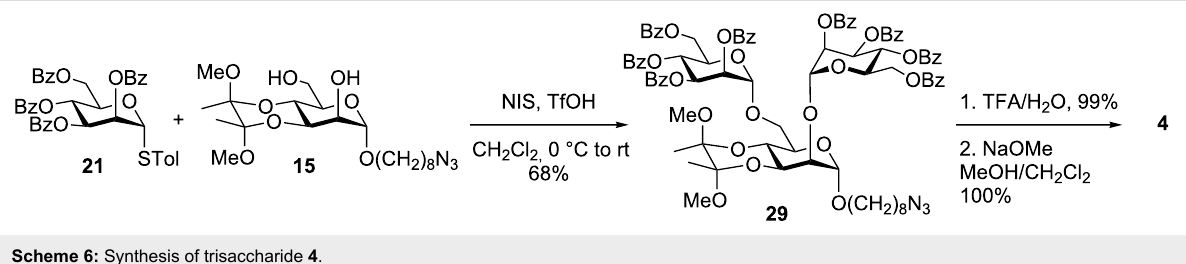
Scheme 6: Synthesis of trisaccharide 4